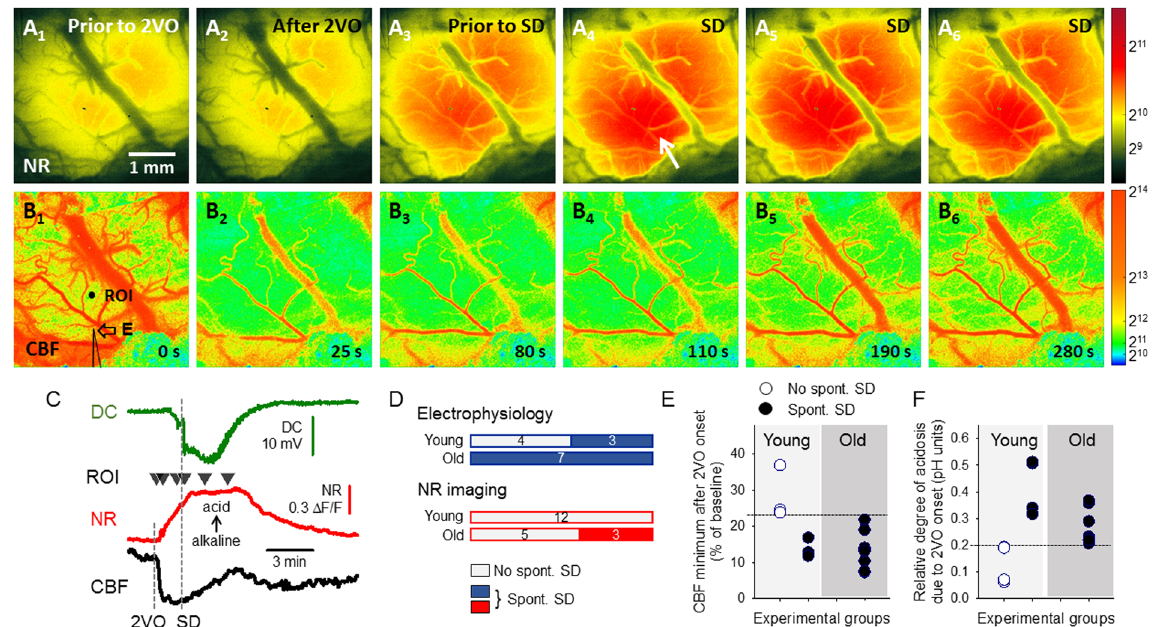
Figure 5. Representative raw image sequences and graphs displaying relative variations illustrate synchronous changes in Neutral Red (NR) fluorescence ( A ), cerebral blood flow (CBF) ( B ), and direct current (DC) potential ( C ), with the propagation of a spontaneous spreading depolarization (SD) wave in the ischemic cerebral cortex of an old rat. Pseudo-colored NR images in Panel A were derived from monochrome images relying on a 16-bit grayscale, while pseudo-colored CBF maps (16-bit resolution) in Panel B display speckle contrast perfusion units. Scale bars to the right represent the used ranges of gray levels. In Panel A4, the entry to the field of view and direction of propagation of a spontaneous SD is shown by a white arrow. In Panel B1, the penetration site of the glass capillary electrode ( E ) inserted to acquire electrophysiological signals is shown with an arrow, and a region of interest (ROI) indicates the origin of NR and CBF traces shown in Panel C. ( C ) Traces demonstrate the onset of ischemia (2VO) and the evolution of a spontaneous SD as shown by the DC potential signature (green), and the ischemia or SD-related relative changes in NR fluorescence (red) and CBF (black). Small black triangles pointing down over the NR traces designate the origin of the representative images shown in Panels A,B. ( D–F ) Conditions that favor the spontaneous occurrence of SD shortly after ischemia onset are presented. ( D ) Ratio of experiments devoid of spontaneous SD (white) and in which spontaneous SD occurred (colored). Each horizontal box represents the total number of experiments taken as 100%, and the number of rats is given in the middle of bars. ( E ) Drop of CBF after ischemia induction, depicted for each experiment involving pH-sensitive microelectrodes. ( F ) The relative amplitude of acidosis induced by ischemia alone, measured directly prior to the detection of SD, for each experiment involving pH-sensitive microelectrodes. Horizontal lines drawn in E and F indicate a theoretical level of threshold for the evolution of spontaneous